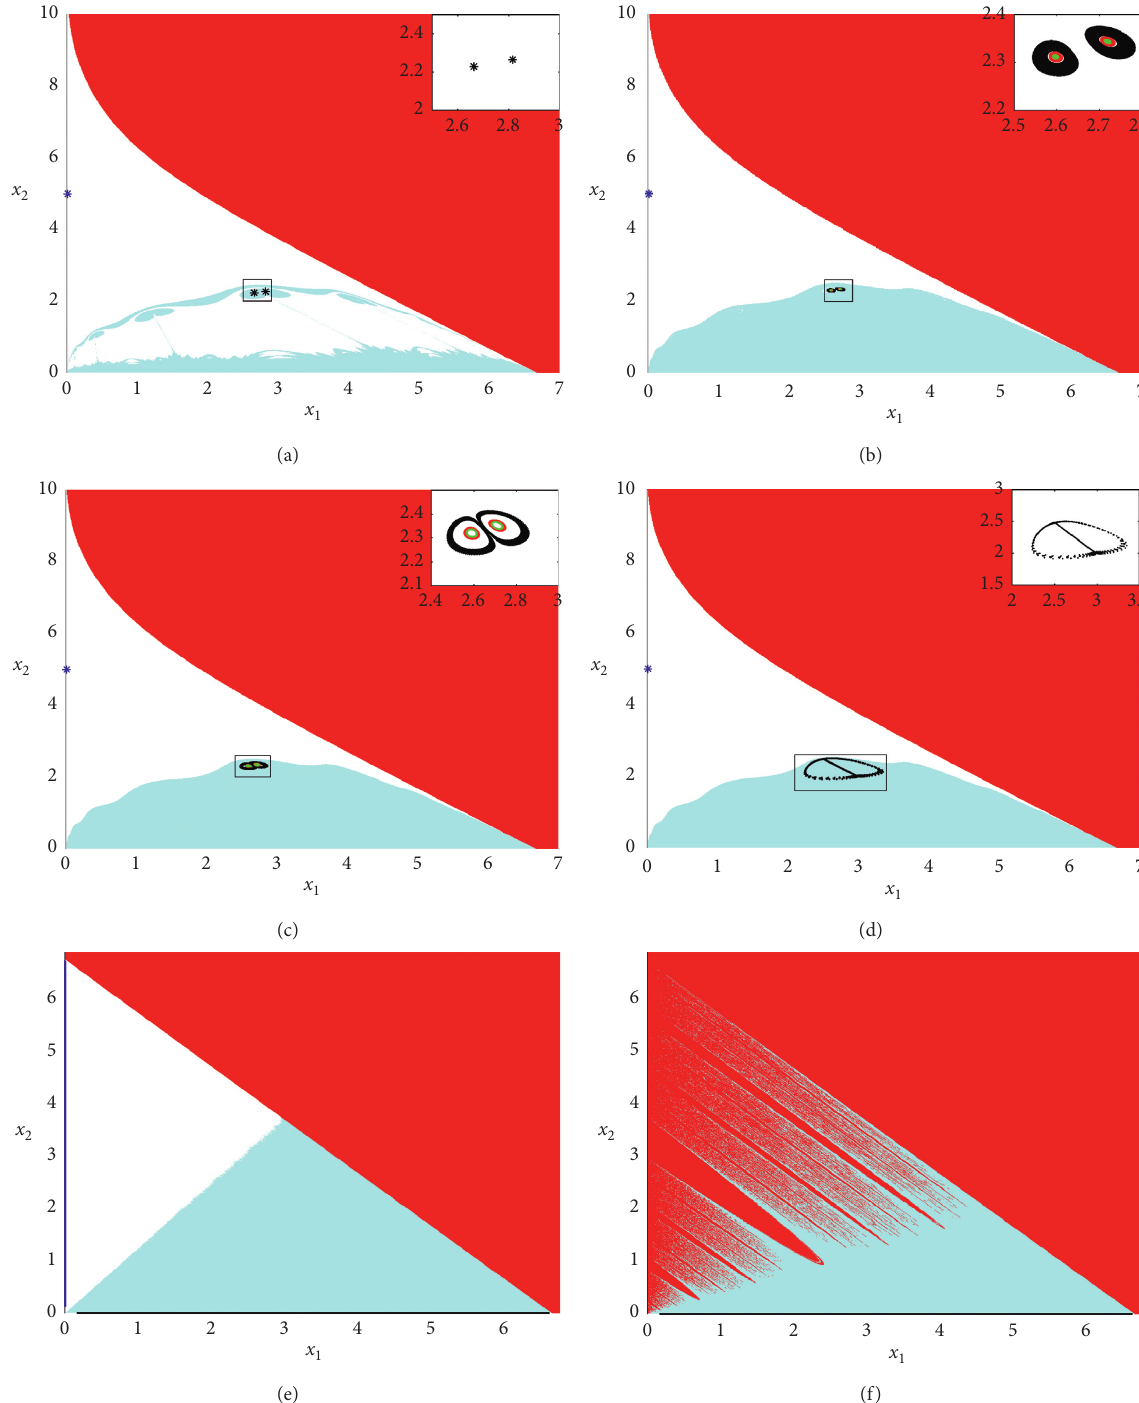
Figure 6: The evolution of basin of attraction of system (10) with respect to parameter α � 0 . 48; (e) α α 2